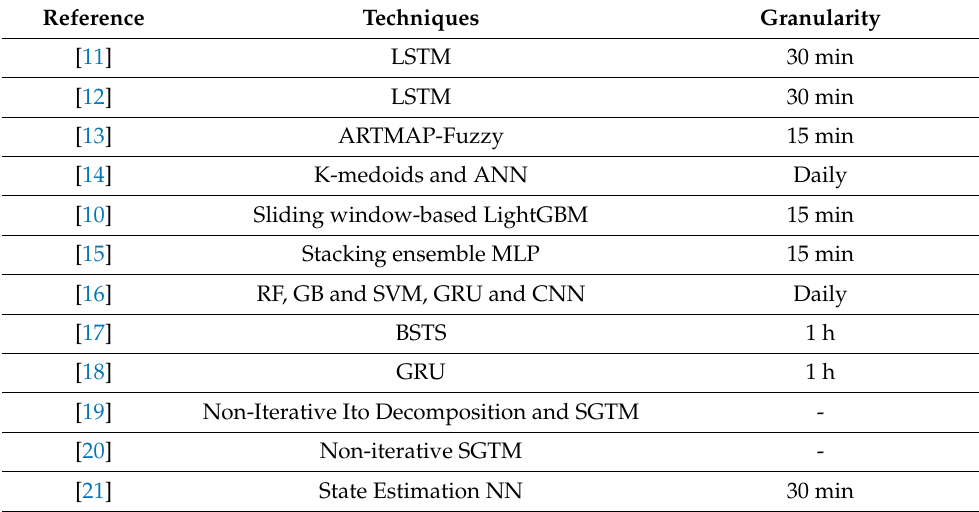
Table 1. Summary of the related